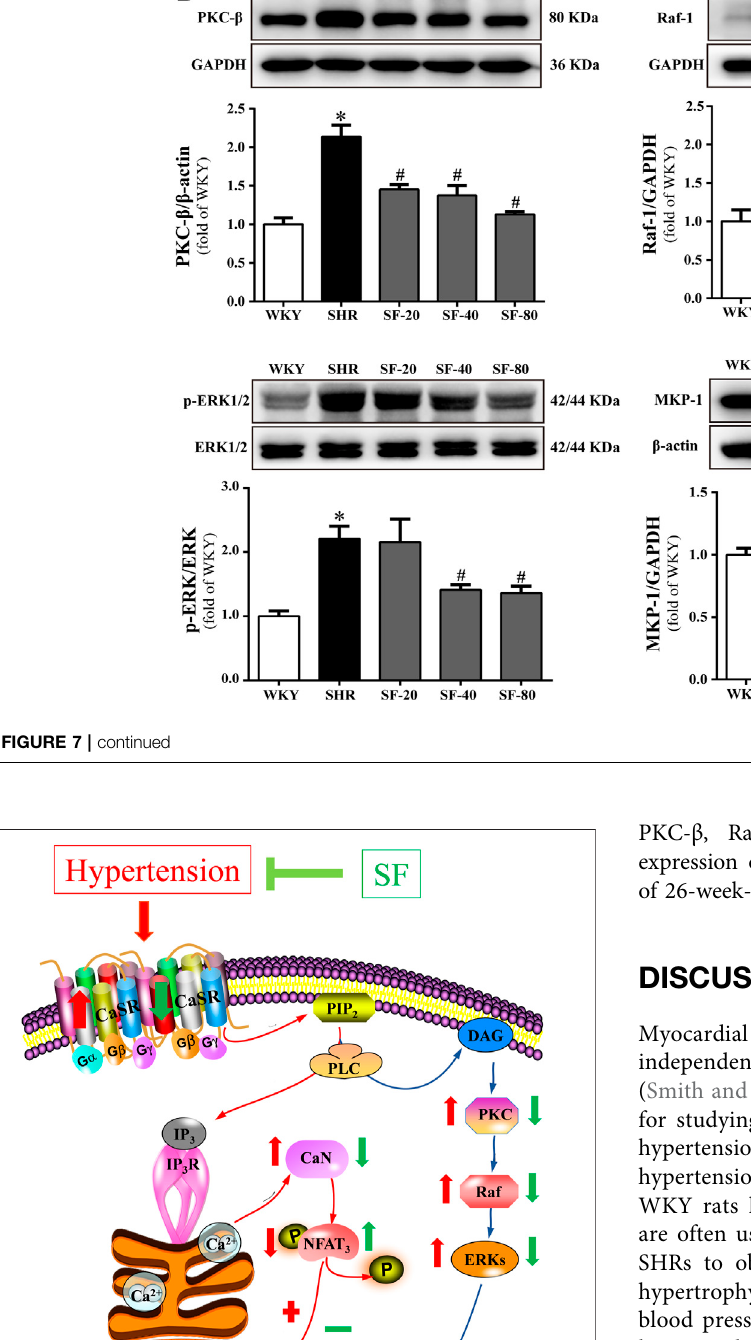
Frontiers in Pharmacology |